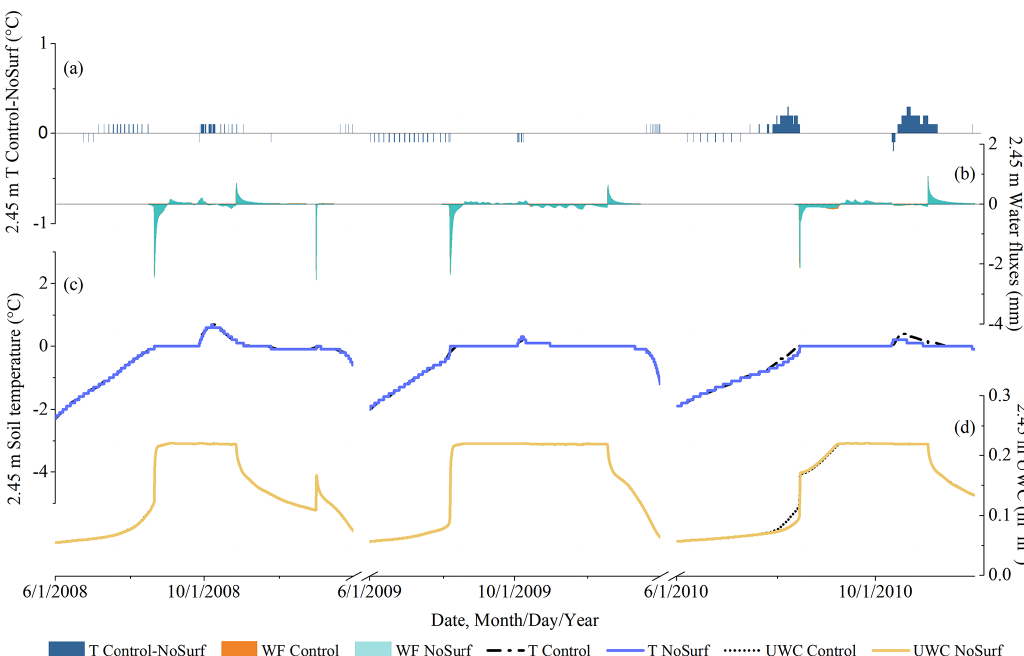
Figure 10. Hourly soil temperature, water flux, and UWC at 2.45m depth, representative of the deep depths, simulated under NoSurf and Control during the 2008–2010 thaw periods. The same notations as in Fig. 6 are